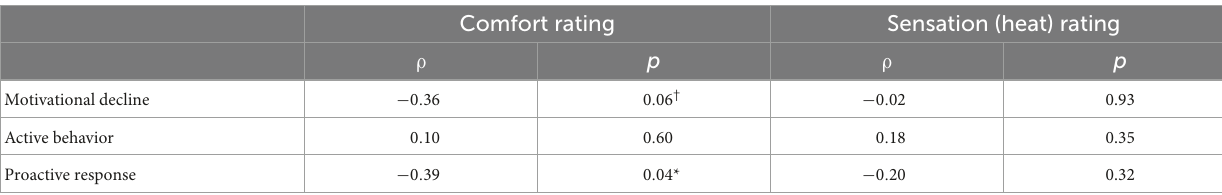
TABLE 3 Correlation between the MTASQ scores and the comfort and sensation